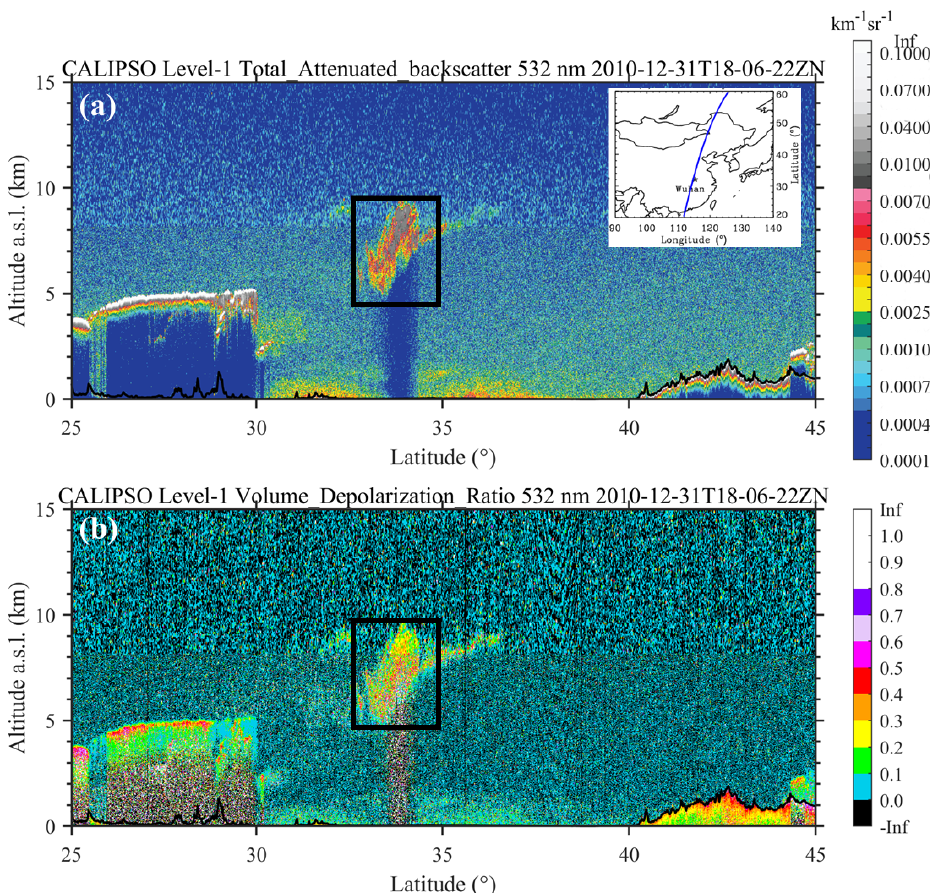
Figure 7. CALIPSO altitude–orbit cross section measurements of the CALIOP Level-1B 532nm (a) total attenuated backscatter coeffi- cient and (b) volume depolarization ratio product on 31 December 2010. The corresponding orbit is 2010-12-31T18-06-22ZN. The black rectangles mark the dust-related cirrus